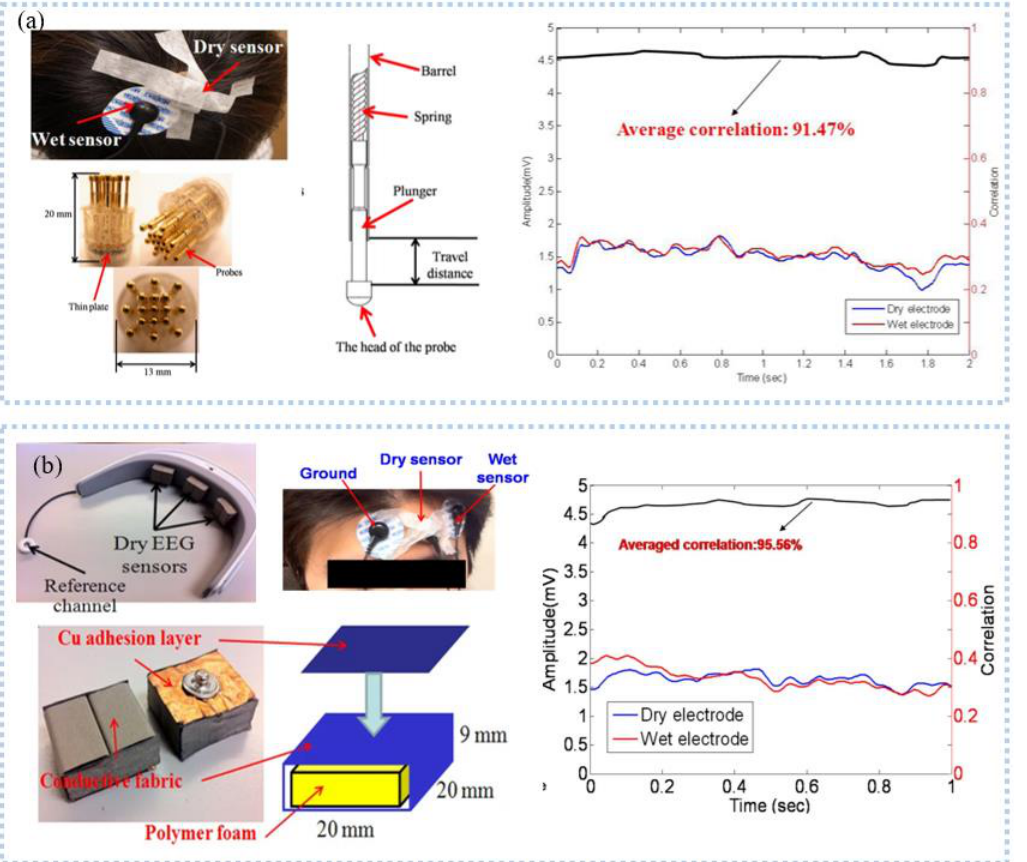
Figure 3. EEG signal detection: ( a ) spring electrode for monitoring EEG in the presence of hair, and had a high agreement with the wet electrode. Reprinted with permission from Ref. [38]. Copyright 2011 MDPI, ( b ) a wearable EEG acquisition device with a dry foam EEG sensor for collecting EEG at the forehead . Reprinted with permission from Ref . [45]. Copyright 2012 Springer Nature .